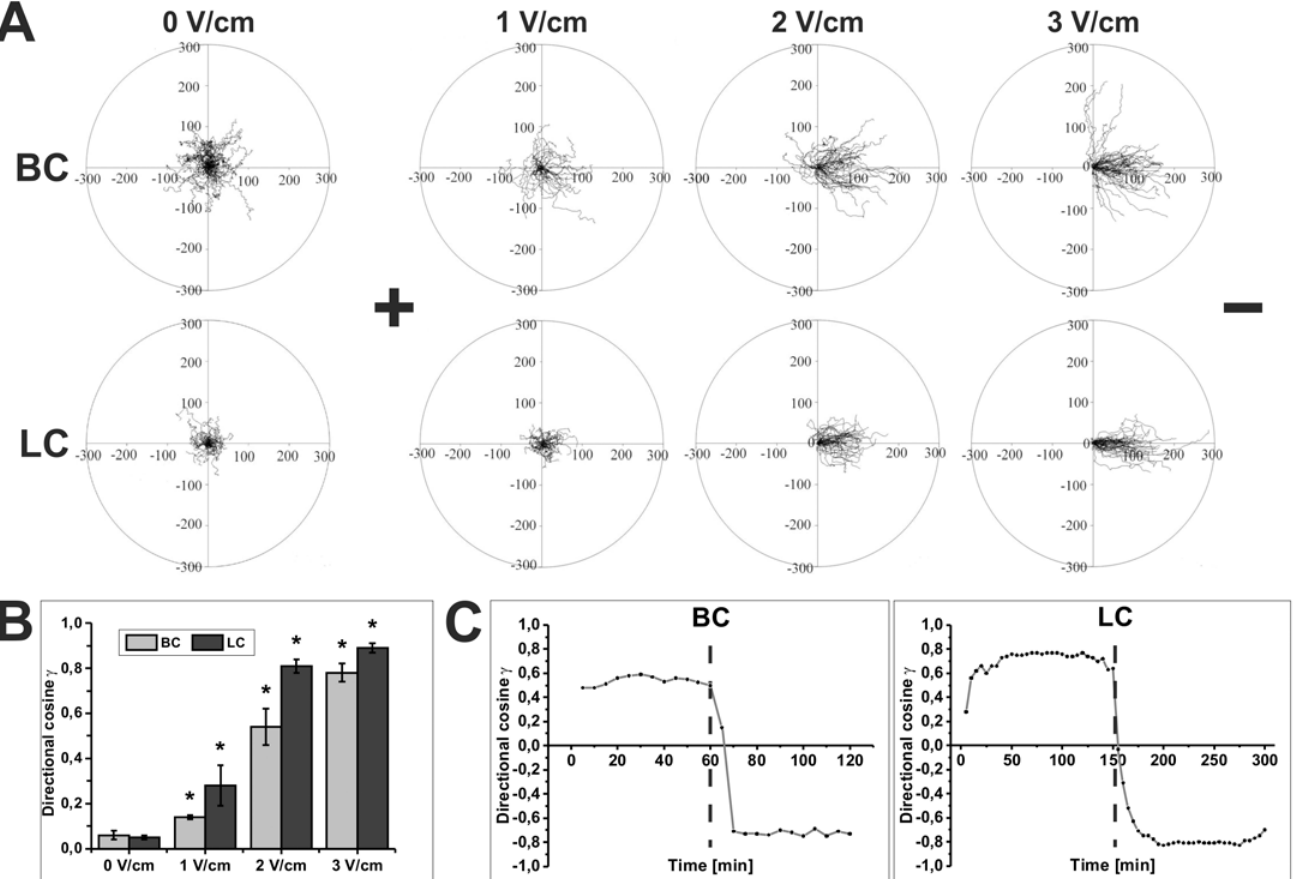
Fig 4. The effect of dcEF on the migration of BC and LC cells. (A) Composite trajectories of BC and LC cells migrating in the absence and in the presence of dcEFs are shown as circular diagrams. In each diagram, the initial point of each trajectory was placed at the center of the circle. The x-axis corresponds to the direction of the electric field. The cathode was always placed at the right side of the diagram. Each trajectory was constructed from 120 (BC) or 48 (LC) successive positions of cell centroids recorded at 15-sec (BC) or 150-sec (LC) time intervals, immediately after the exposure of cells to dcEF. The movement of BC and LC was recorded for 30 minutes and 150 minutes, respectively. ( B ) Diagrams presenting the values of directional cosines γ for BC and LC cells depending on applied field strength; mean ± SEM; p < 0.05 vs 0 V/cm ( C ) The dynamics of reversibility of the direction of cell movement. The directionality of cell movement was completely reversible upon reversing the field polarity (3V/cm). For both cell sublines the average directional cosines γ were analyzed every 5 minutes. Perpendicular lines indicate the time when the electric field polarity was reversed (n = 50). * Statistically significant vs. 0 V/cm (p <